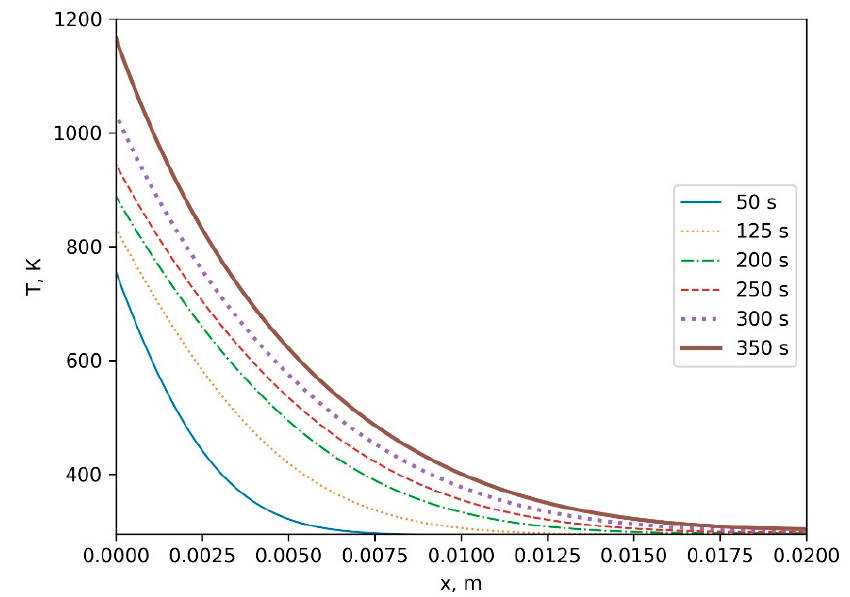
Figure 11. Impact of a surface forest fire (high intensity) on plywood from a distance of 20 m— temperature distribution along the wall thickness.